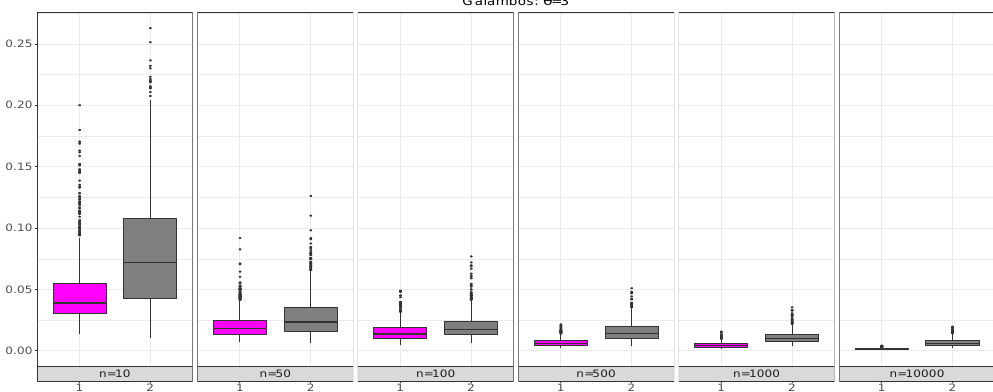
Figure 3: Boxplot summarizing the L 1 -distance of the 1000 obtained estimates (pink: estimator based on ˆ A * n , gray: estimator based on checkerboard approximations) for CoVaR = ( Y | X ) at level γ = 0.05 . α , γ , C A 3